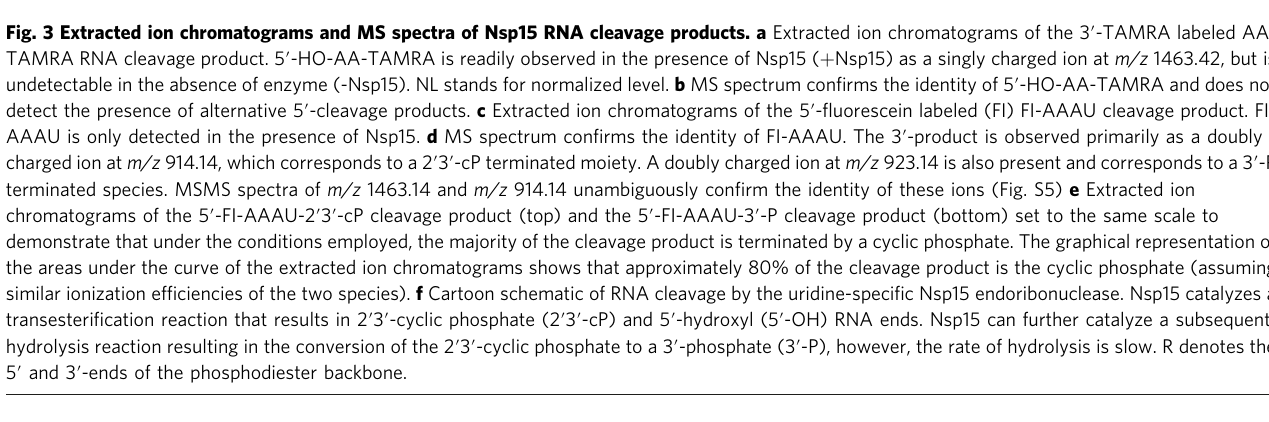
Fig. 3 Extracted ion chromatograms and MS spectra of Nsp15 RNA cleavage products. a Extracted ion chromatograms of the 3 ′ -TAMRA labeled AA- TAMRA RNA cleavage product. 5 ′ -HO-AA-TAMRA is readily observed in the presence of Nsp15 ( + Nsp15) as a singly charged ion at m/z 1463.42, but is undetectable in the absence of enzyme (-Nsp15). NL stands for normalized level. b MS spectrum con fi rms the identity of 5 ′ -HO-AA-TAMRA and does not detect the presence of alternative 5 ′ -cleavage products. c Extracted ion chromatograms of the 5 ′ - fl uorescein labeled (FI) FI-AAAU cleavage product. FI- AAAU is only detected in the presence of Nsp15. d MS spectrum con fi rms the identity of FI-AAAU. The 3 ′ -product is observed primarily as a doubly charged ion at m/z 914.14, which corresponds to a 2 ′ 3 ′ -cP terminated moiety. A doubly charged ion at m/z 923.14 is also present and corresponds to a 3 ′ -P terminated species. MSMS spectra of m/z 1463.14 and m/z 914.14 unambiguously con fi rm the identity of these ions (Fig. S5) e Extracted ion